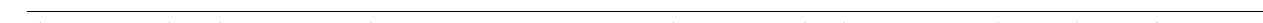
Fig. 6 An HSF1-dependent transcriptional program suppresses TDP-43 acetylation-mimic-induced aggregation. a Schematic diagram of HSF1 constructs highlighting active and inactive mutations. The regulatory domain (RD) was deleted and a single L395E was introduced to generate active HSF1, while R71G represents inactive HSF1. DBD DNA-binding domain, HR hydrophobic heptad repeat domain. b Cells were transfected with TDP-43- Δ NLS-K145Q in combination with the various HSF1 constructs (or control pCDNA vector) followed by biochemical fractionation and immunoblotting using the indicated TDP-43, P409/410, HSF1-HA, or GAPDH antibodies. Shown is a representative image containing duplicate samples from N = 3 independent experiments. c TDP-43 and phospho-TDP-43 levels from b were quanti fi ed by densitometry. d Cells expressing constructs similar to c above were analyzed by immuno fl uorescence using GFP and P409/410 antibodies. White arrows highlight phosphorylated TDP-43 aggregates. e Inclusion formation in d was quanti fi ed. f A sequential transfection was performed fi rst with TDP-43- Δ NLS-K145Q followed by subsequent transfection of HSF1 for another 48 h. Soluble and insoluble fractions were analyzed by immunoblotting using the indicated antibodies. g Insoluble TDP-43 and phospho-TDP-43 were quanti fi ed, showing reduction of pre-formed TDP-43 aggregates by active HSF1. h Cells expressing TDP-43- Δ NLS-K145Q aggregates were exposed to DMSO or HSF1A and analyzed by immuno fl uorescence. i Aggregates were quanti fi ed and normalized to the number of total TDP-43 expressing cells. Error bars indicate SEM, and the asterisk indicates statistical signi fi cance with *** p -value < 0.001 and ** p -value < 0.01, as measured by Student ’ s t -test from N = 3 biological replicates. ns = not signi fi cant. Scale bar = 50 μ